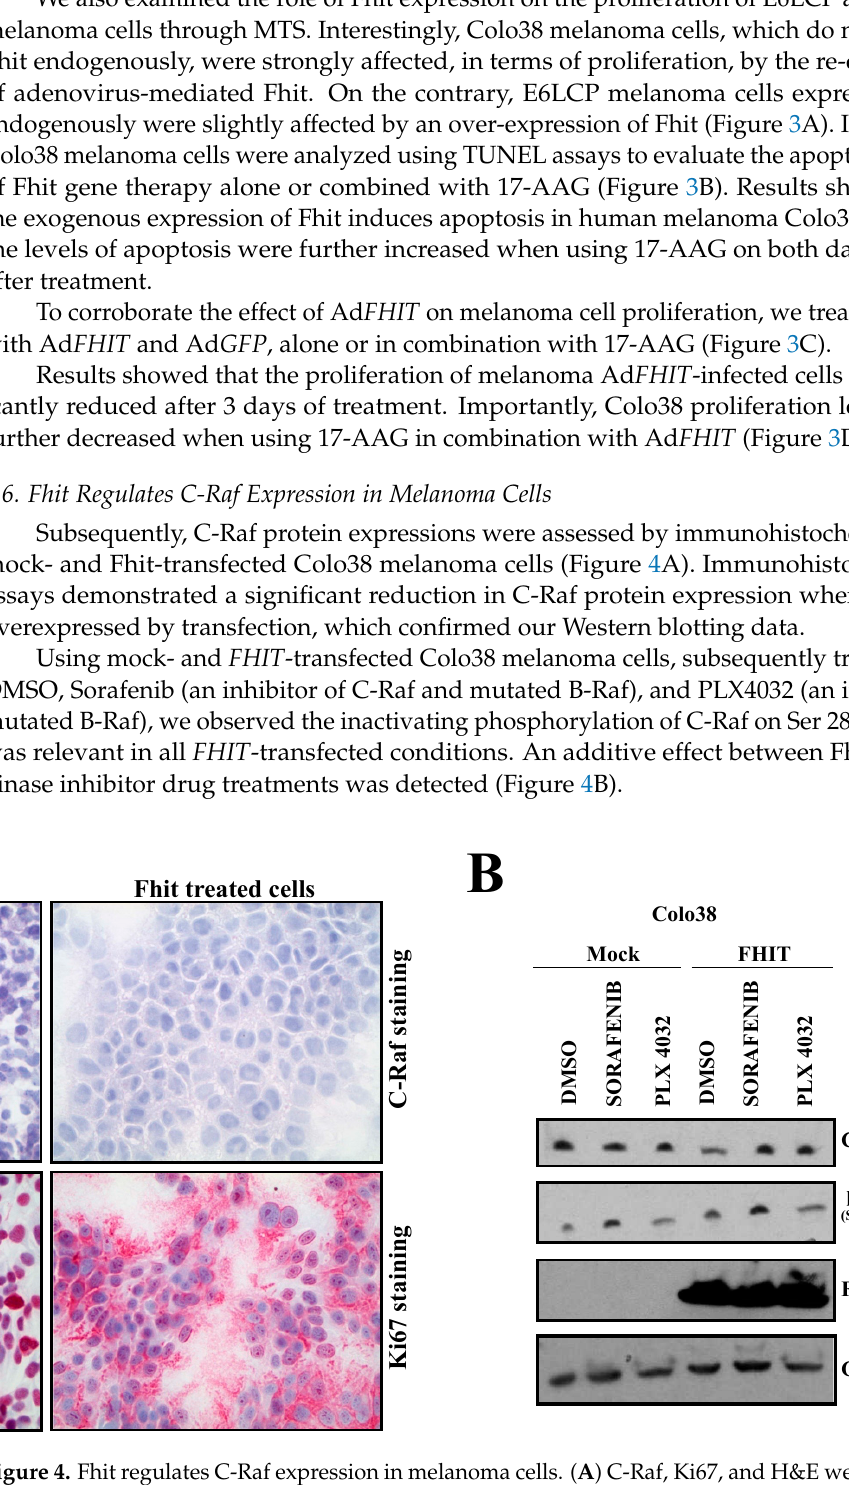
Figure 4. Fhit regulates C-Raf expression in melanoma cells. ( A ) C-Raf, Ki67, and H&E were analyzed through immunohistochemistry in mock- and FHIT -transfected Colo38 melanoma cells. ( B ) Colo38 melanoma cells, mock- or FHIT -transfected, were treated with DMSO, Sorafenib, and PLX4032. Then, cell lysates were immunoblotted with C-Raf, p-C-RAF, FHIT, and GAPDH antibodies.